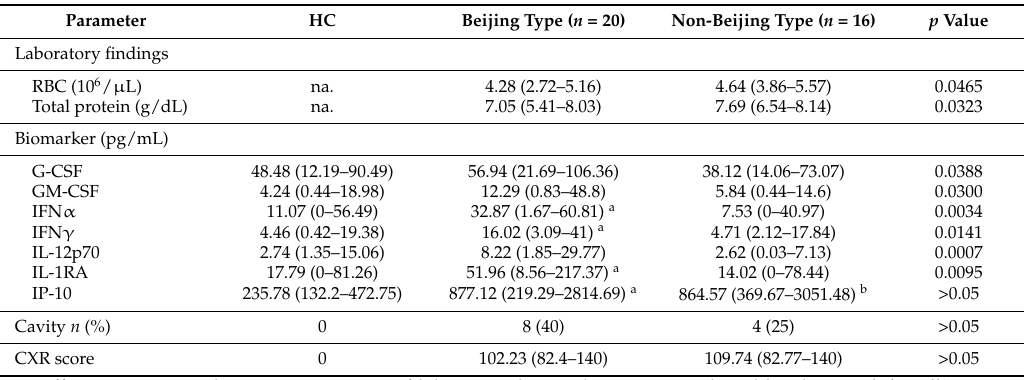
Table 7. Laboratory and biomarker values in patients infected by Beijing or non-Beijing strains of Mycobacterium tuberculosis